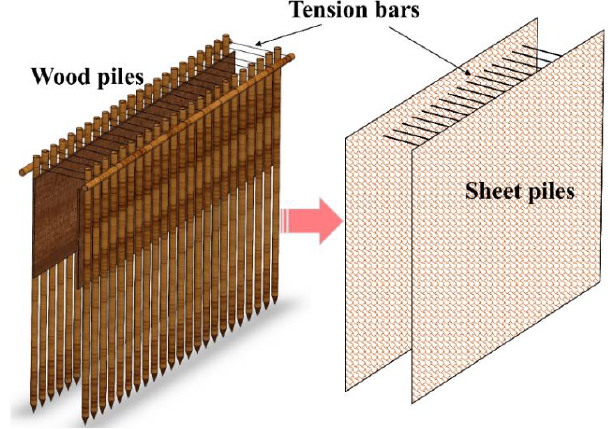
Figure 1. Equivalence of cofferdam structure.